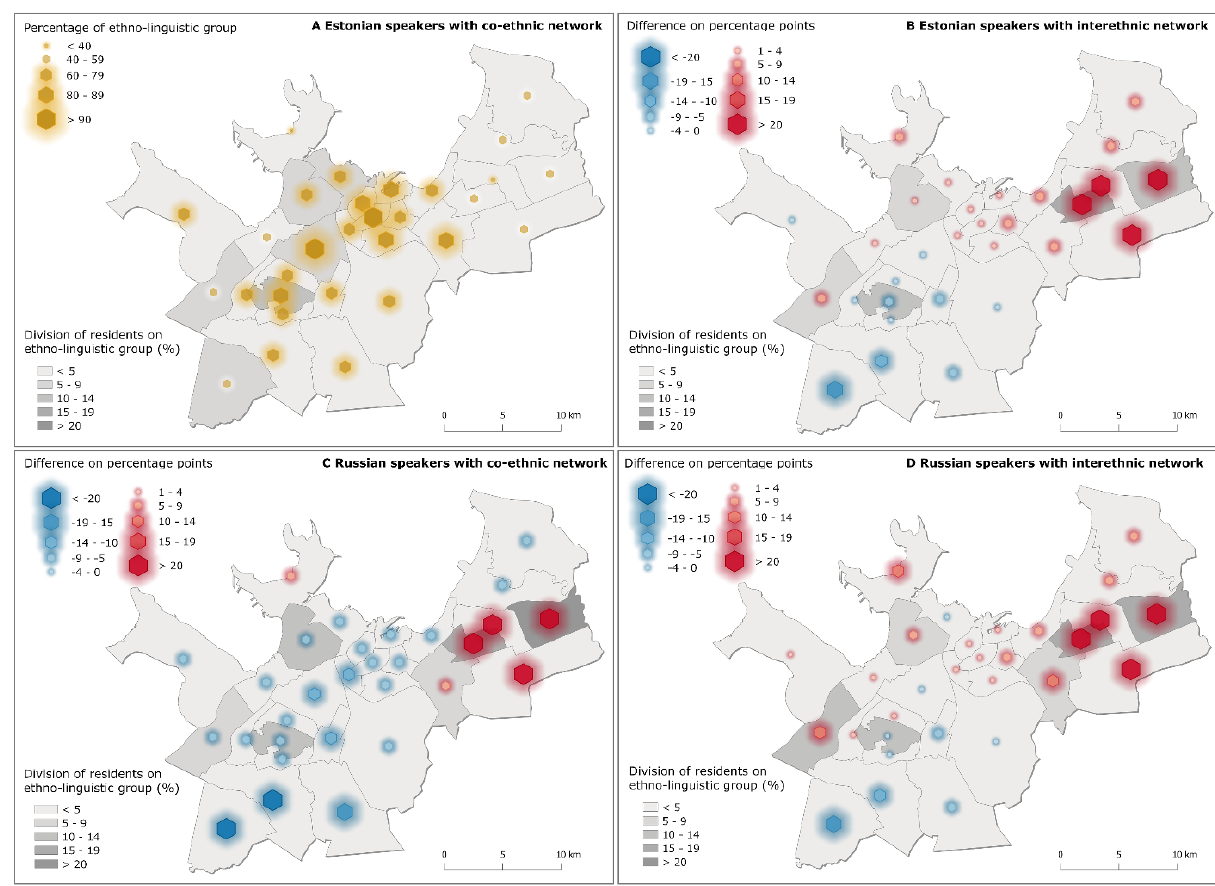
Figure 5. Comparison of visited districts in Tallinn by ethno-linguistic background and network composition: (A) Estonian speakers with co-ethnic networks (reference category), (B) Estonian speakers with interethnic networks, (C) Russian speak- ers with co-ethnic networks, and (D) Russian speakers with interethnic networks. Differences are presented as percentage points (weighted